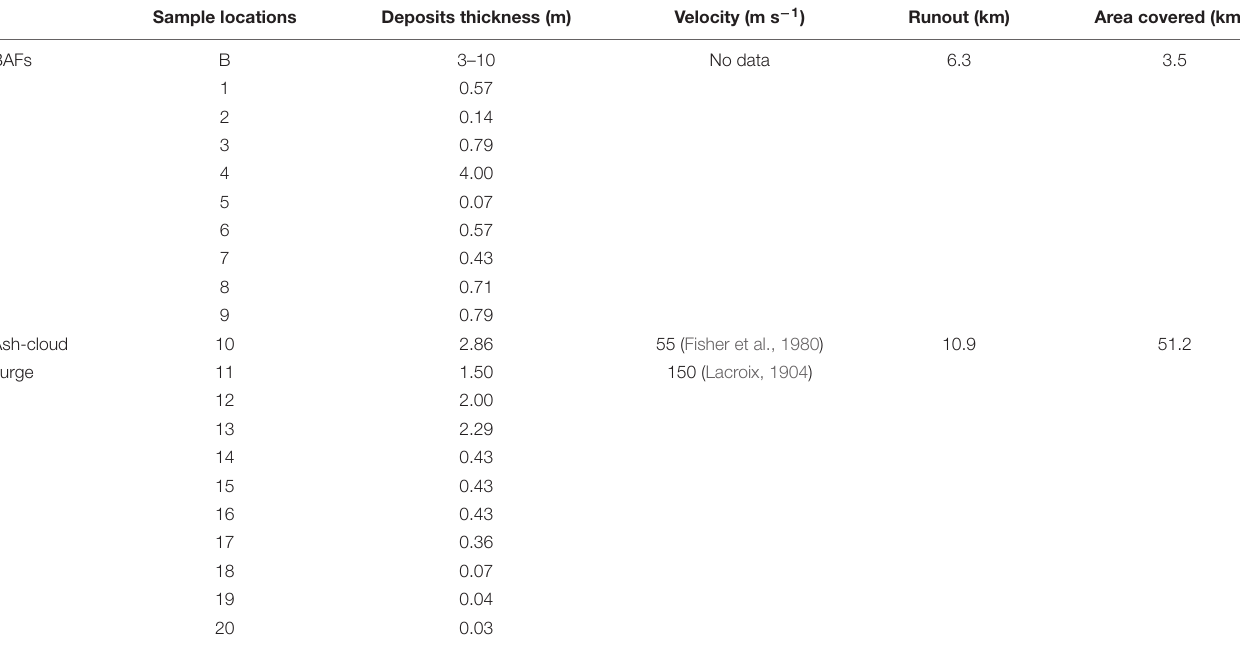
TABLE 1 | Compilation of field data of the May 8th, 1902 eruption at Mount Pelée. Sample locations refer to the white numbers in Figure 1 . Sample locations